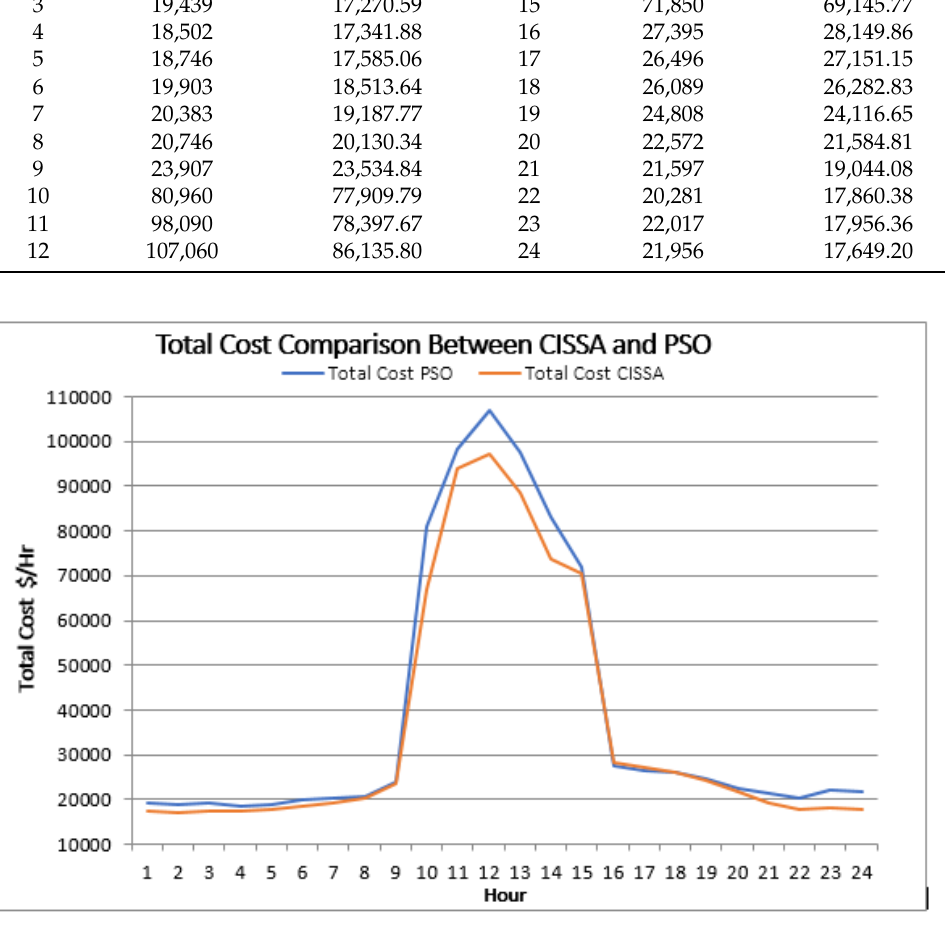
Figure 12. Comparison of total cost of CISSA and PSO.